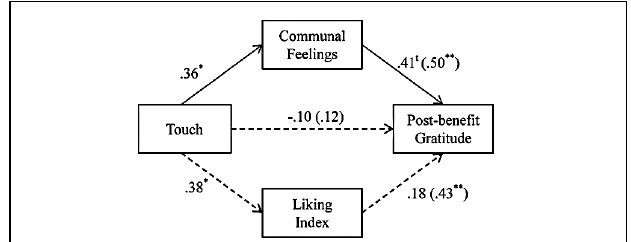
FIGURE 2 | Results of the regression analysis corroborating that the effect of touch on post-benefit gratitude is mediated by communal feelings (vs. liking) in Study 1. The numbers are standardized regression coefficients. The numbers outside parentheses represent β -weights when all variables are used concurrently as predictors, whereas the numbers in parentheses are zero-order correlations. t p < 0.10; ∗ p < 0.05; ∗∗ p < 0.01.